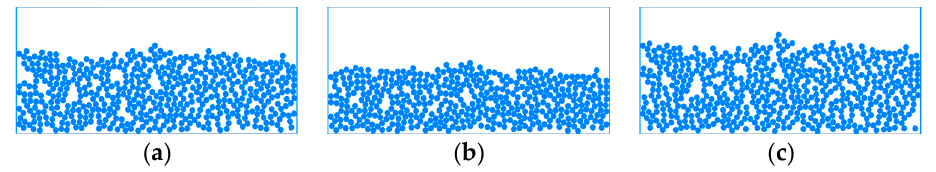
Figure 2. Comparison of deposition morphologies under different particle densities and rolling resistance coefficients (only layers 7, 8 and 9 are shown). ( a ) ρ = 1000, α = 0.2; ( b ) ρ = 2500, α = 0.2; ( c ) ρ = 1000, α = 0.5.